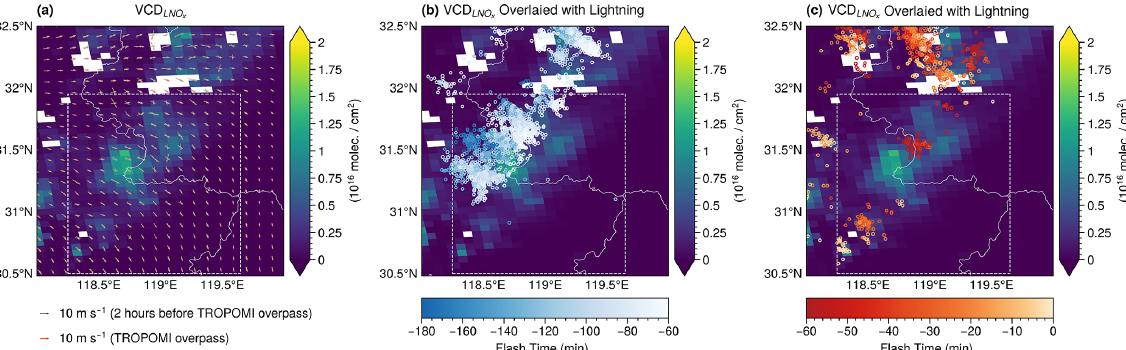
). The white rectangles are manually selected x